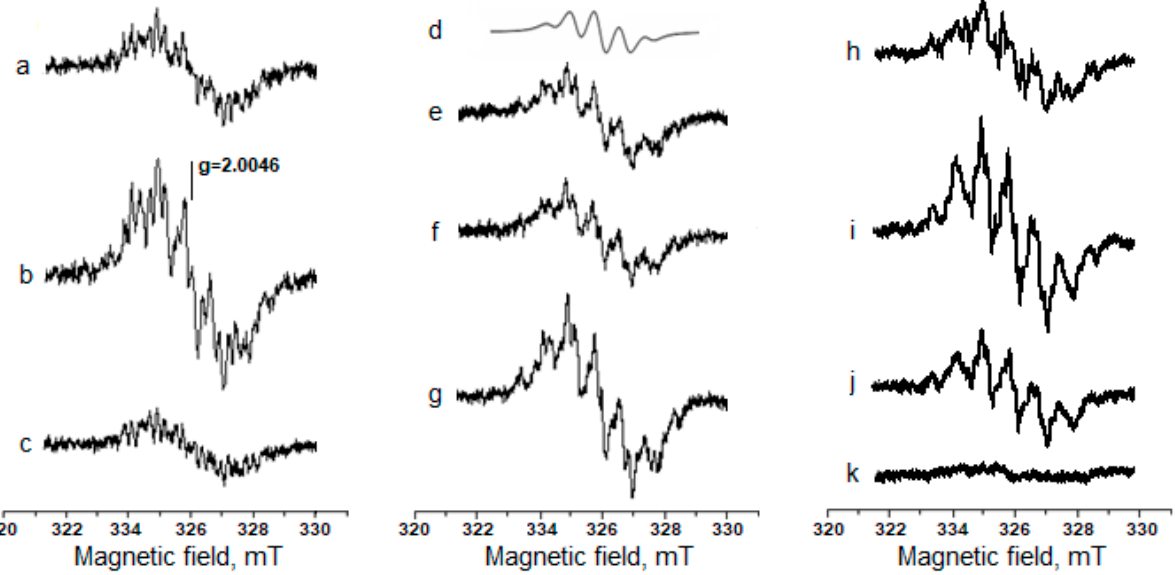
Figure 3. EPR spectra of MG anion radicals and dialkylimine cation radicals formed in the Maillard reaction. The reaction mixture: 0.2 M K, Na-phosphate buffer (pH 8.0), 160 mM MG, and 160 mM (spectra a-c ) or 80 mM (spectra e-f ) lysine, or 160 mM N α -acetyllysine (spectra h-k ). The simulation of the EPR spectra of MG cis-anion radicals ( d ). During various experiments, 4 mM GSNO (b, g), 4 mM Angeli’s salt ( c ); 1 mM DTPA ( f, h-k ); 4 mM CysNO ( i , j ) or 1.25 mM DNICs with cysteine ligands ( j ) were added to the reaction mixture. EPR spectra were recorded 10.5 min after mixing the com- ponents with nitrogen purging ( a-j ) or with aeration during the last 4 min of incubation ( k ). High- frequency modulation amplitude—0.2 mT.